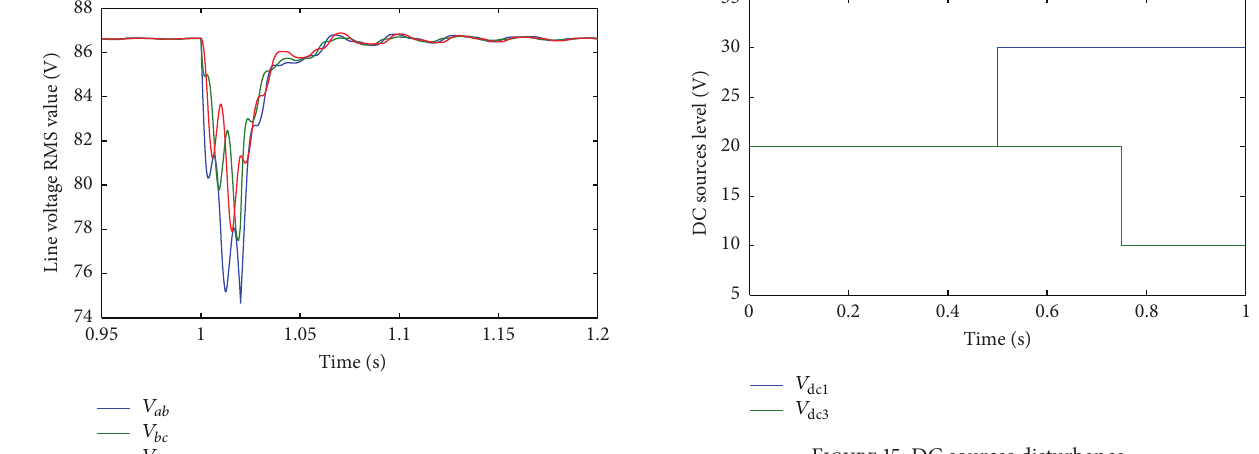
Figure 15: DC sources